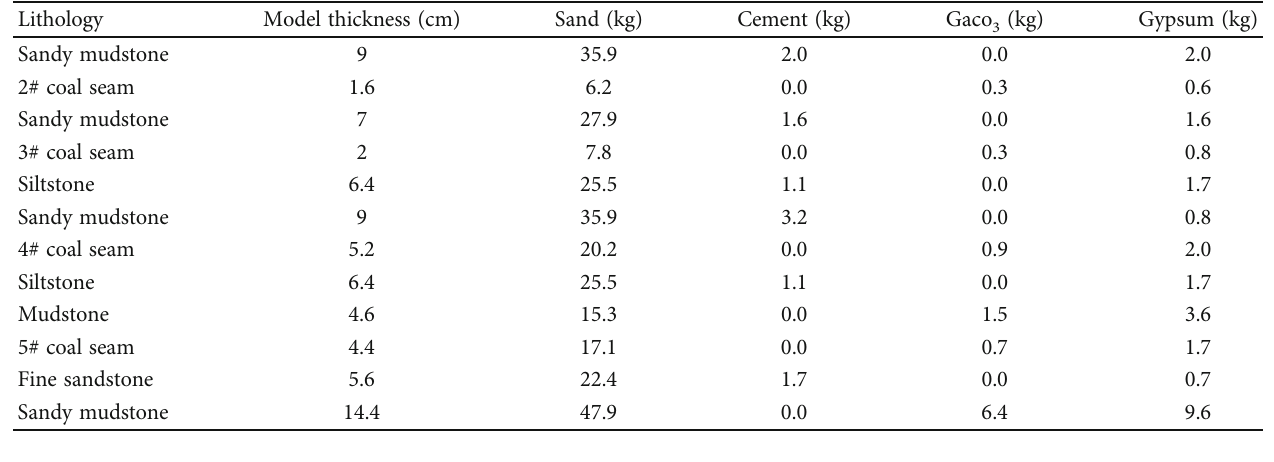
Table 2: Similar material ratio of the